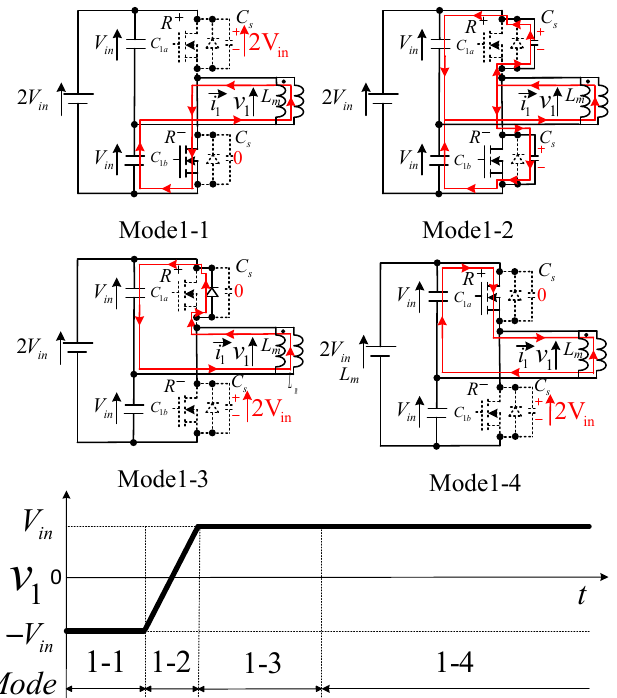
Figure 5. Soft-switching modes of primary half-bridge converter.